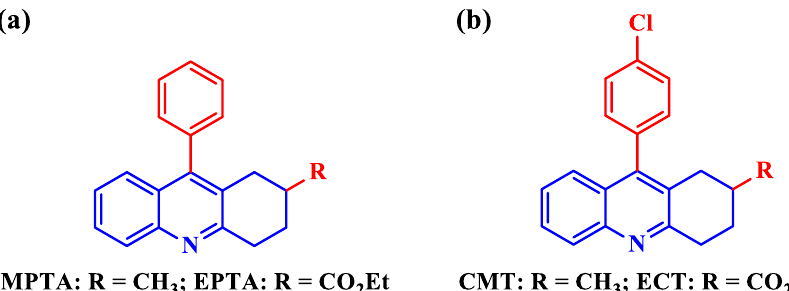
Figure 3. 9-Phenyl substituted ( a ) 9-(4-chlorophenyl) and ( b ) tetrahydroacridines.